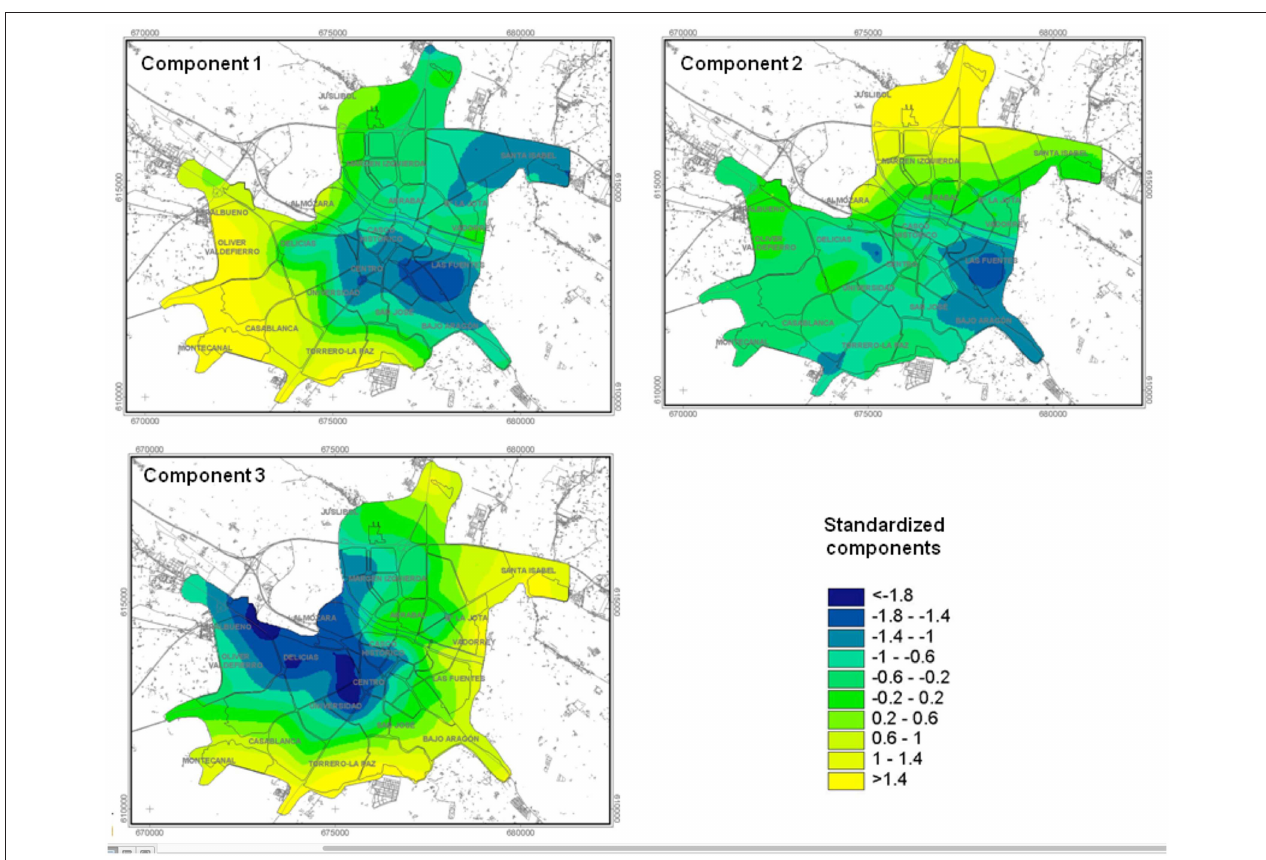
FIGURE 6 | Spatial distribution of rotated PCAs from standardized relative air humidity.